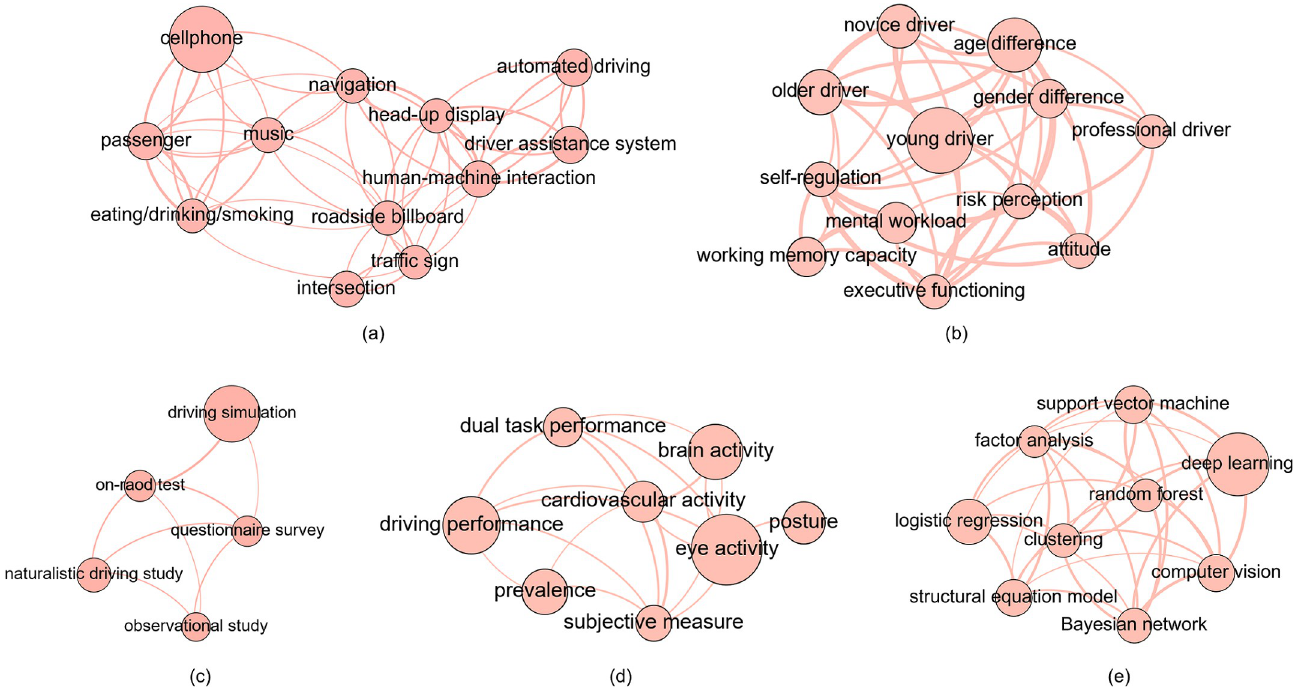
Fig 8. Visualization of the main entities under each